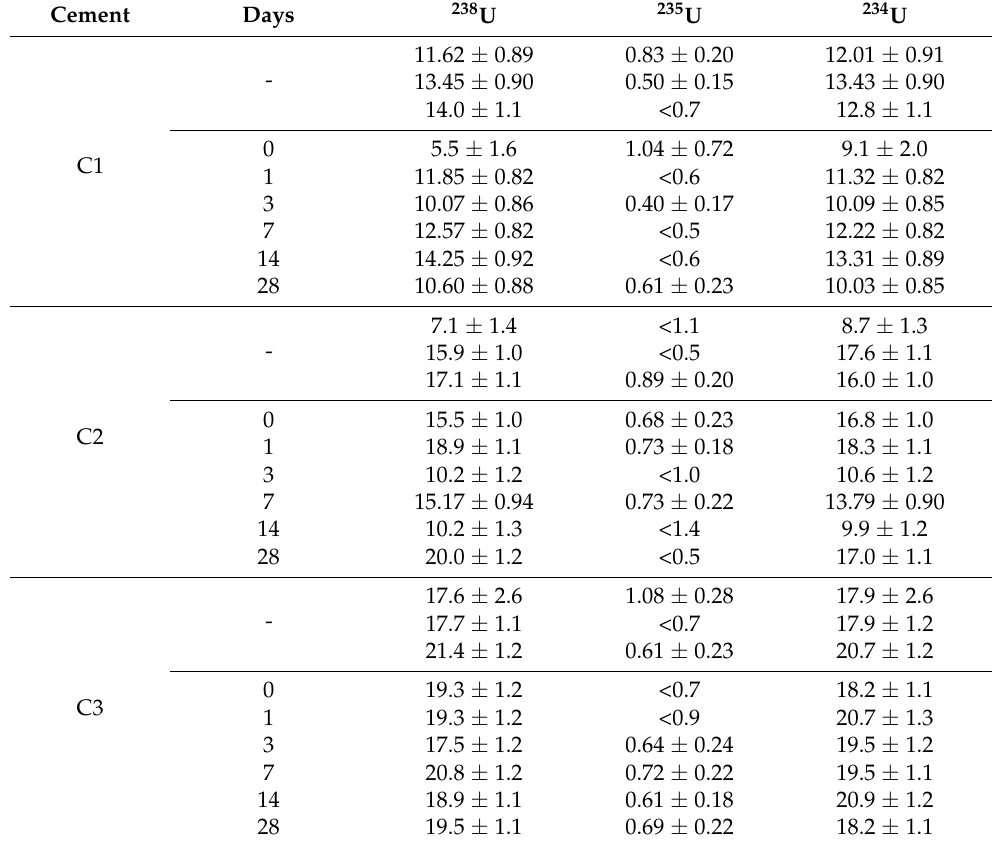
Table 3. Activity concentrations of 238 U, 235 U, and 234 U of powdered mortars determined by radio- chemical